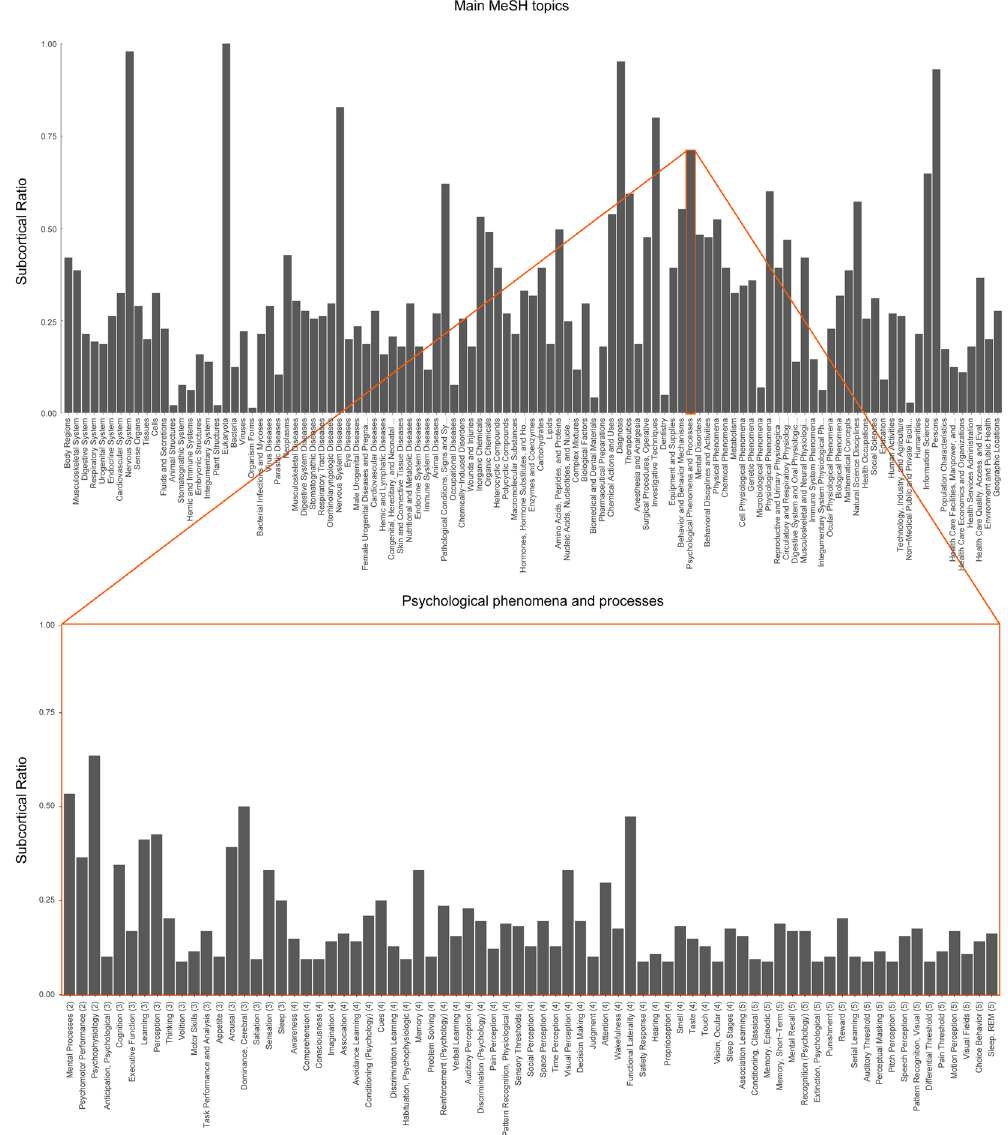
Figure 2. Proportion of subcortical structures associated with the MeSH topics. The proportion of the 145 subcortical structures that are associated with a given MeSH topic (x-axis). Top panel: The ratio for the top-level MeSH topics are displayed. Bottom panel: The ratio for the most frequently associated cognitive subtopics of the “ Psychological phenomena and processes ” branch are displayed. For visualization purposes only, we selected the “ Psychological phenomena and processes ” topics that had at least 13 publications associated with them. Note that this number was arbitrarily chosen to ensure manageable figure dimensions. The data and code to generate the figure without this filter can be found on